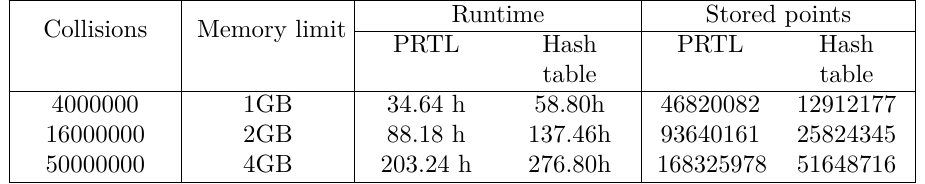
Table 8: Runtime for multi-collision search for a 55-bit curve using PRTLs and hash tables. Values for 1GB memory limit are an average of 100 runs and values for 2GB and 4GB memory limits are an average of 10